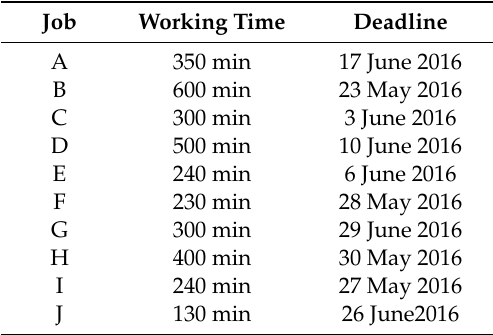
Table 6. Jobs for the spring